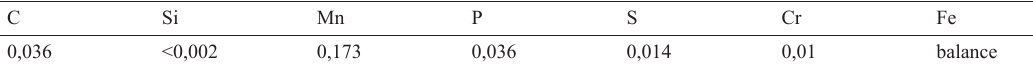
Table 1: Chemical composition of AISI 1005 (wt.%).